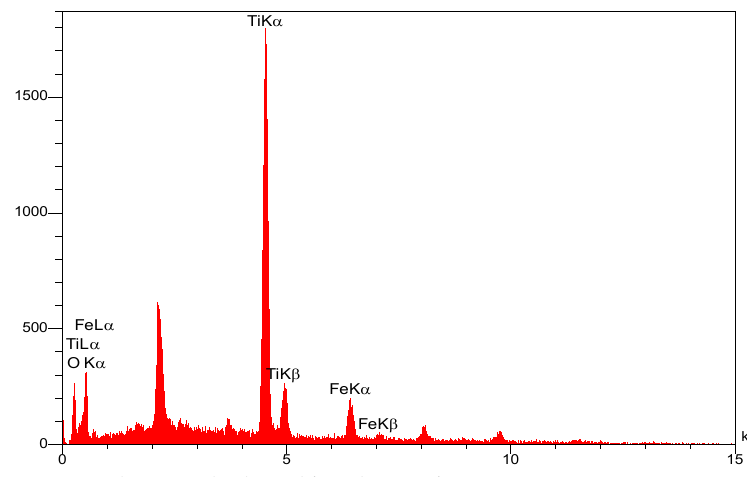
Fig. 9. Qualitative results obtained from the EDS of TiO 2 /Fe 3 O 4 /MWCNT nanocomposite